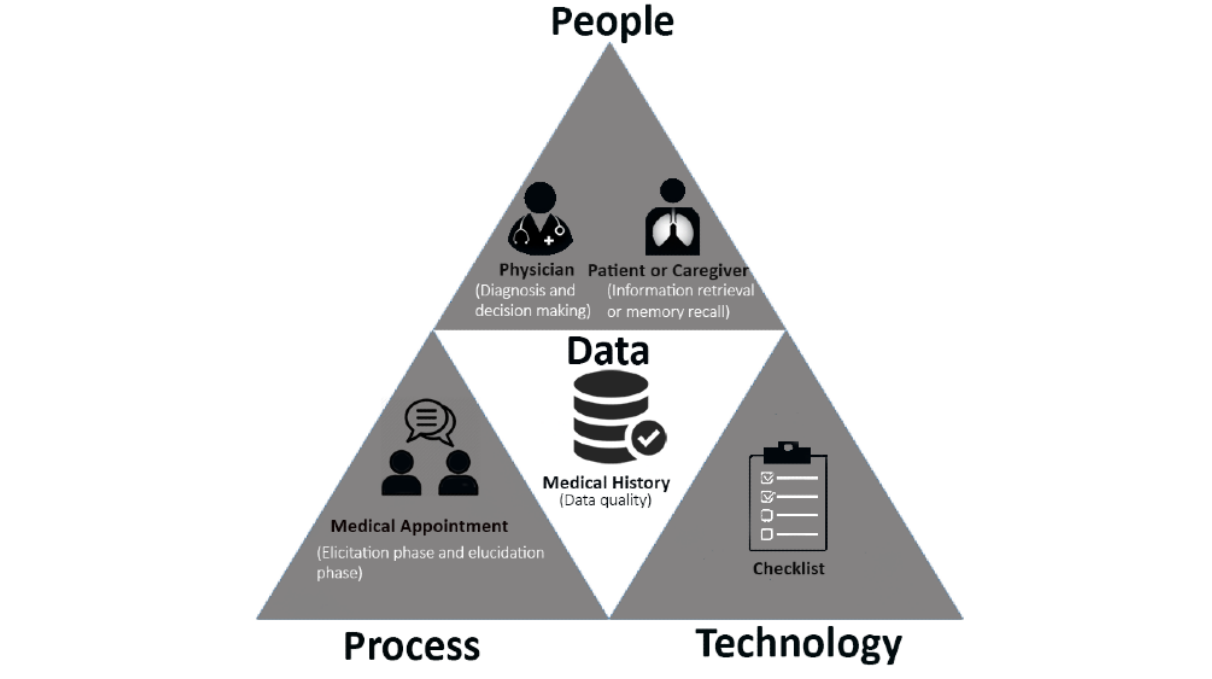
Figure 7. People, process, technology, and